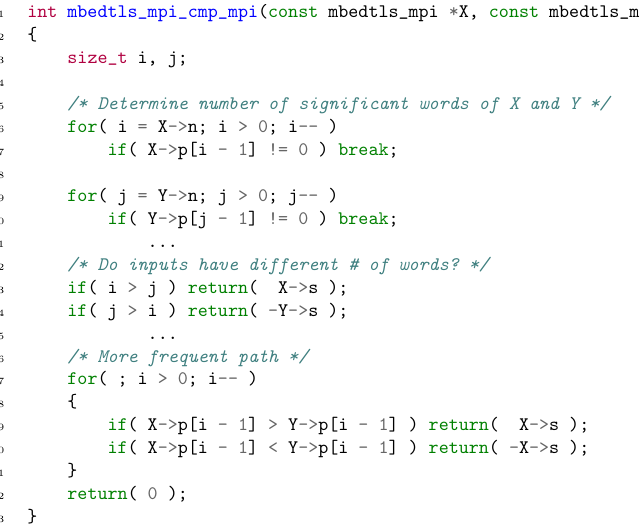
Figure 4: Multiple-precision integer comparison in mbedTLS: mbedtls_mpi_cmp_mpi . 40 iterations. We discuss out-of-group latency samples later. Latencies that are part of a group correspond to the execution of the last loop of mbedtls_mpi_cmp_mpi (Figure